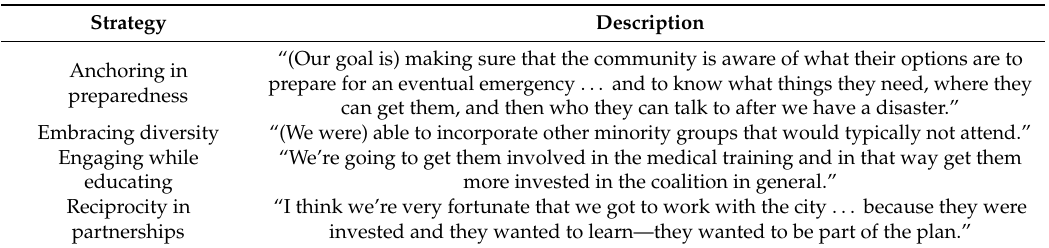
Table 2. Community resilience-building